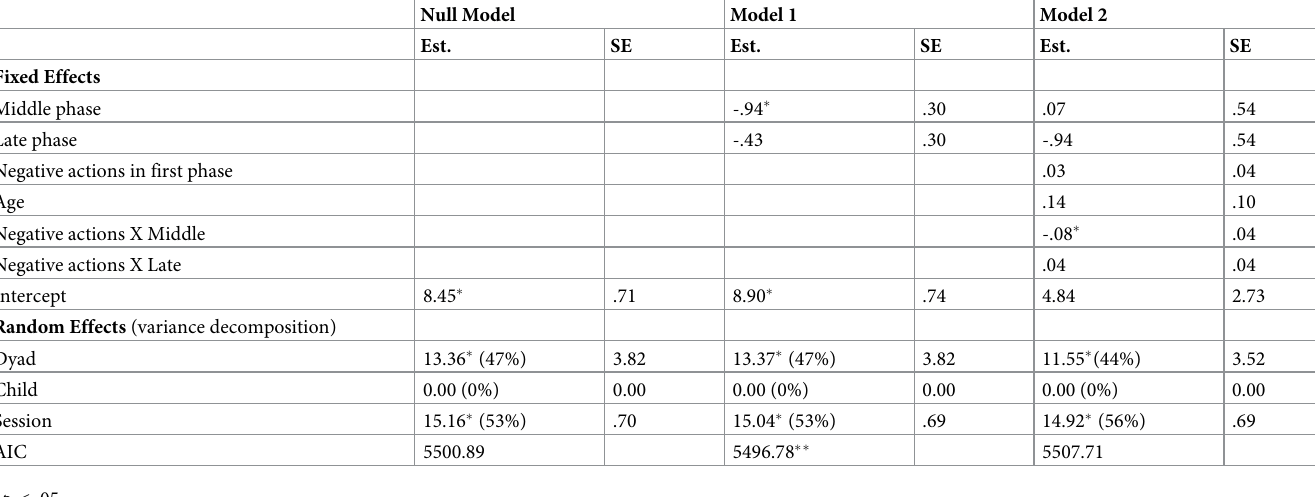
Table 5. Cross-classified multilevel model examining frequency of conflict sequences with phase, negative actions in the first phase, and age as